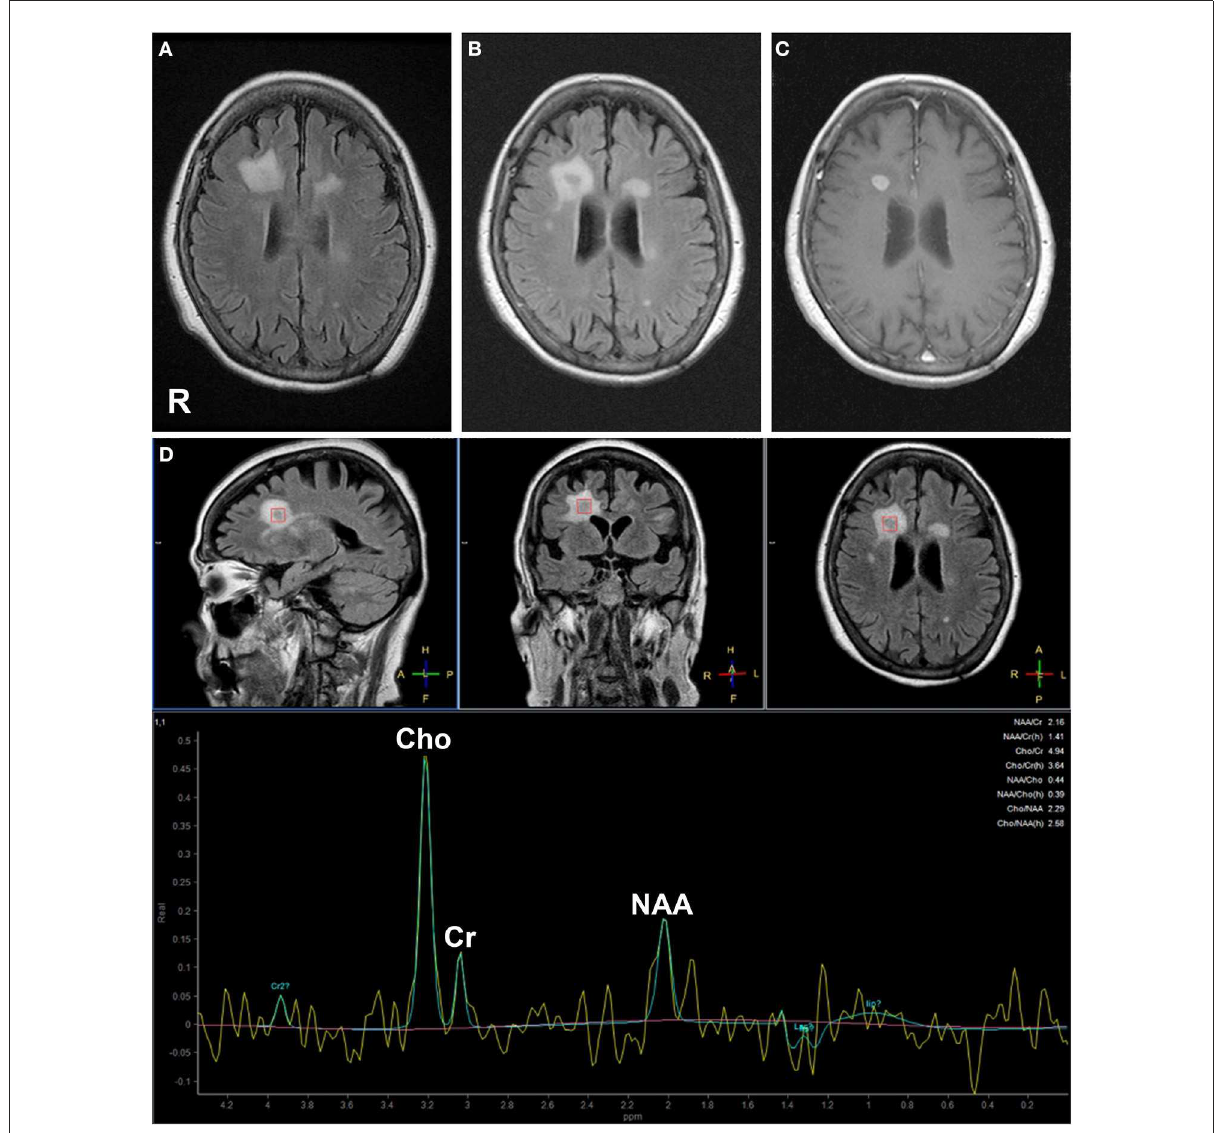
FIGURE1 Brain magnetic resonance (MR) fluid-attenuated inversion recovery (FLAIR) images (A, B) , gadolinium (Gd)-enhanced T1-weighted image (C) , and MR spectroscopy (D) findings. Brain MRI FLAIR 7 days before admission revealed high-intensity lesions in the bilateral frontal lobes (A) . MRI FLAIR (B) and Gd-enhanced T1-weighted image (C) on admission revealed that high-intensity area in the right frontal lobe on MRI FLAIR showed round shaped on Gd enhancement. MR spectroscopy demonstrated an increase in choline/creatine ratio and decrease in N-acetyl aspartate levels in the Gd-enhanced lesion (D)